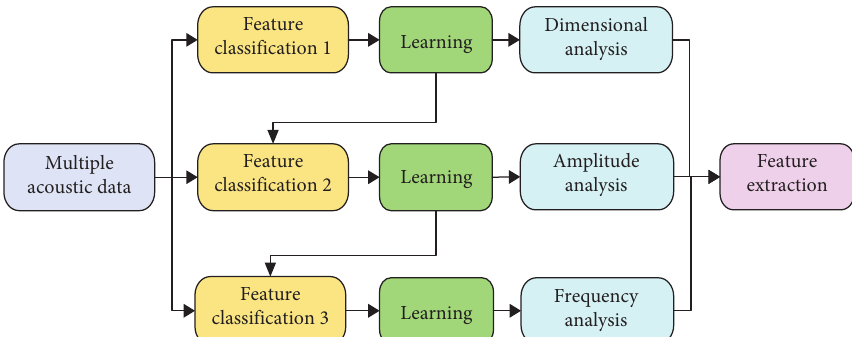
Figure 3: The analysis process of acoustic data from three